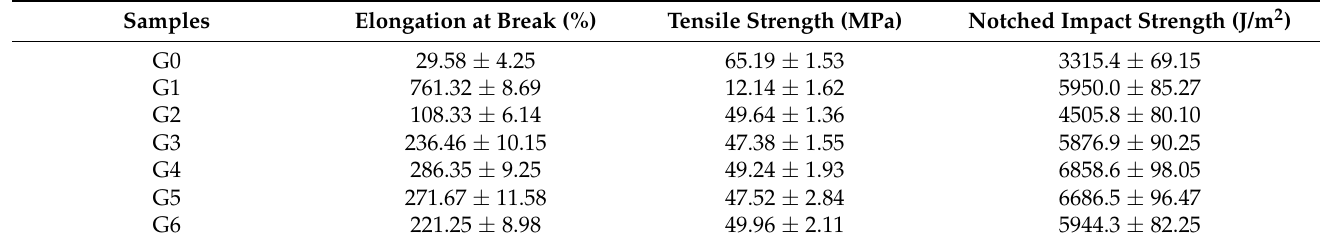
Table 8. Effect of grafted monomers on the mechanical properties of PLA/PPC/PLA-g-GMA